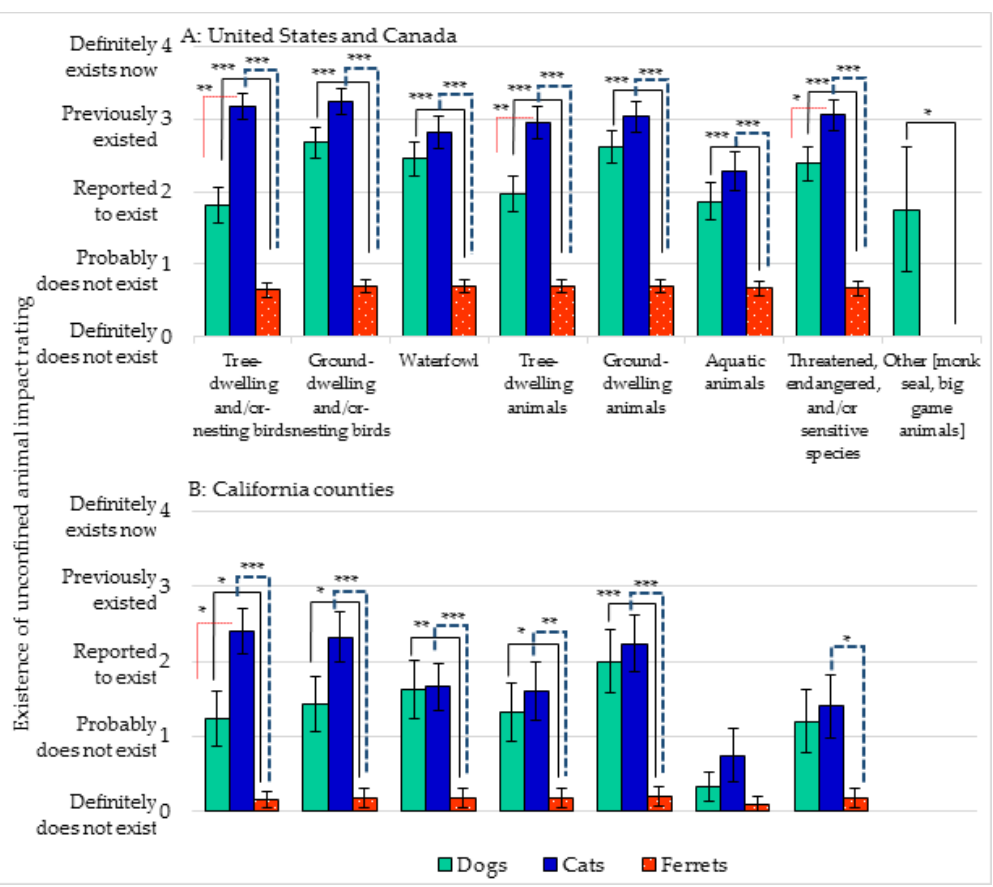
Figure 3. “Existence” of incidents (impact) on wildlife from unconfined dogs, cats, ferrets ( A ) United States, Canada, and ( B ) California counties. Rating mean ± standard error of the mean (sem). Asterisk represents significant difference; * p < 0.05, ** p < 0.01, and *** p <